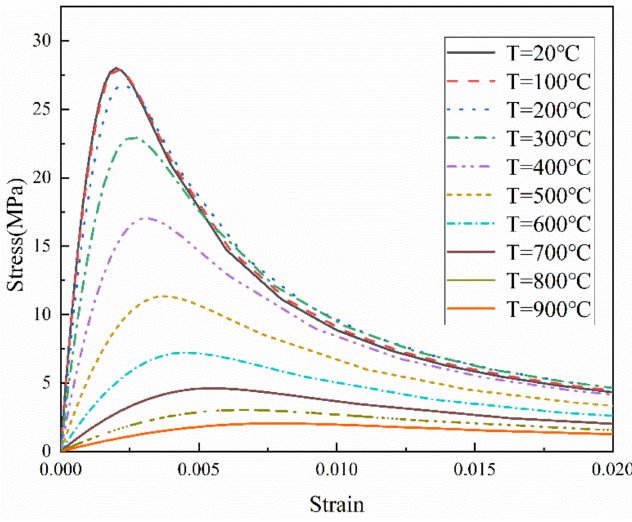
Figure 11. The stress-strain curves of NAC after different